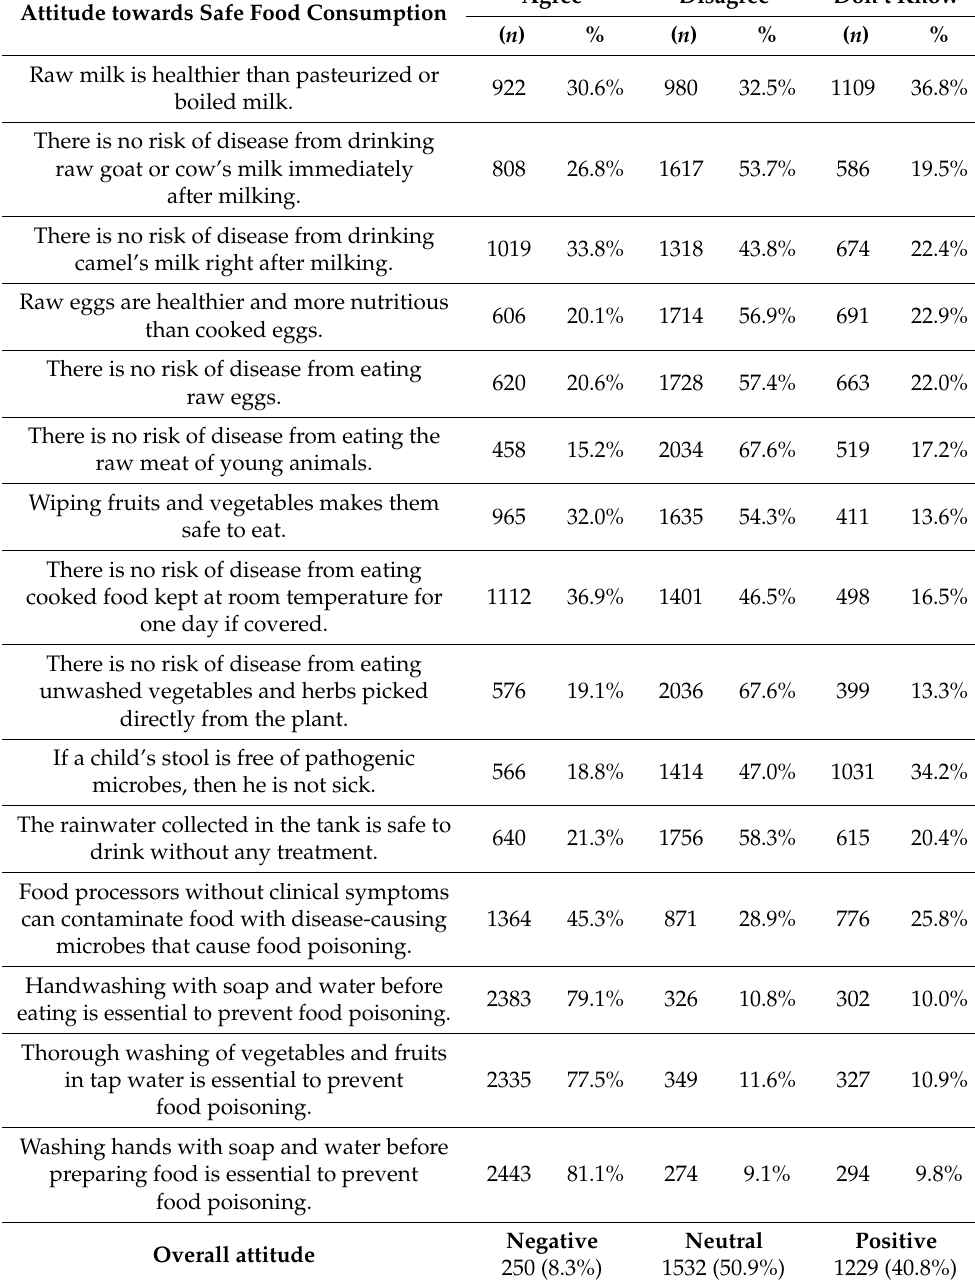
Table 3. Parents’ attitudes towards safe food